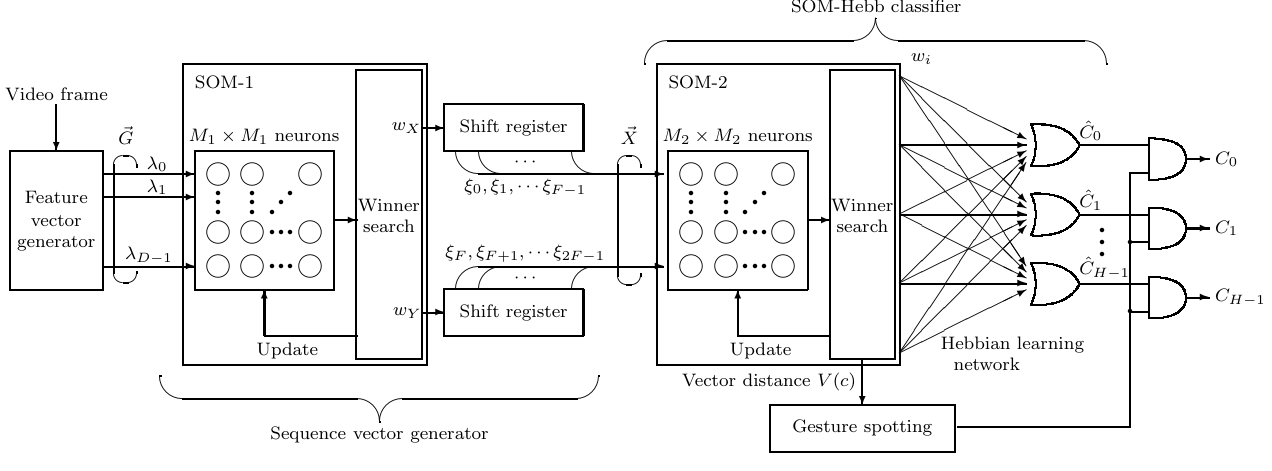
Figure 1. Dynamic gesture recognition system.